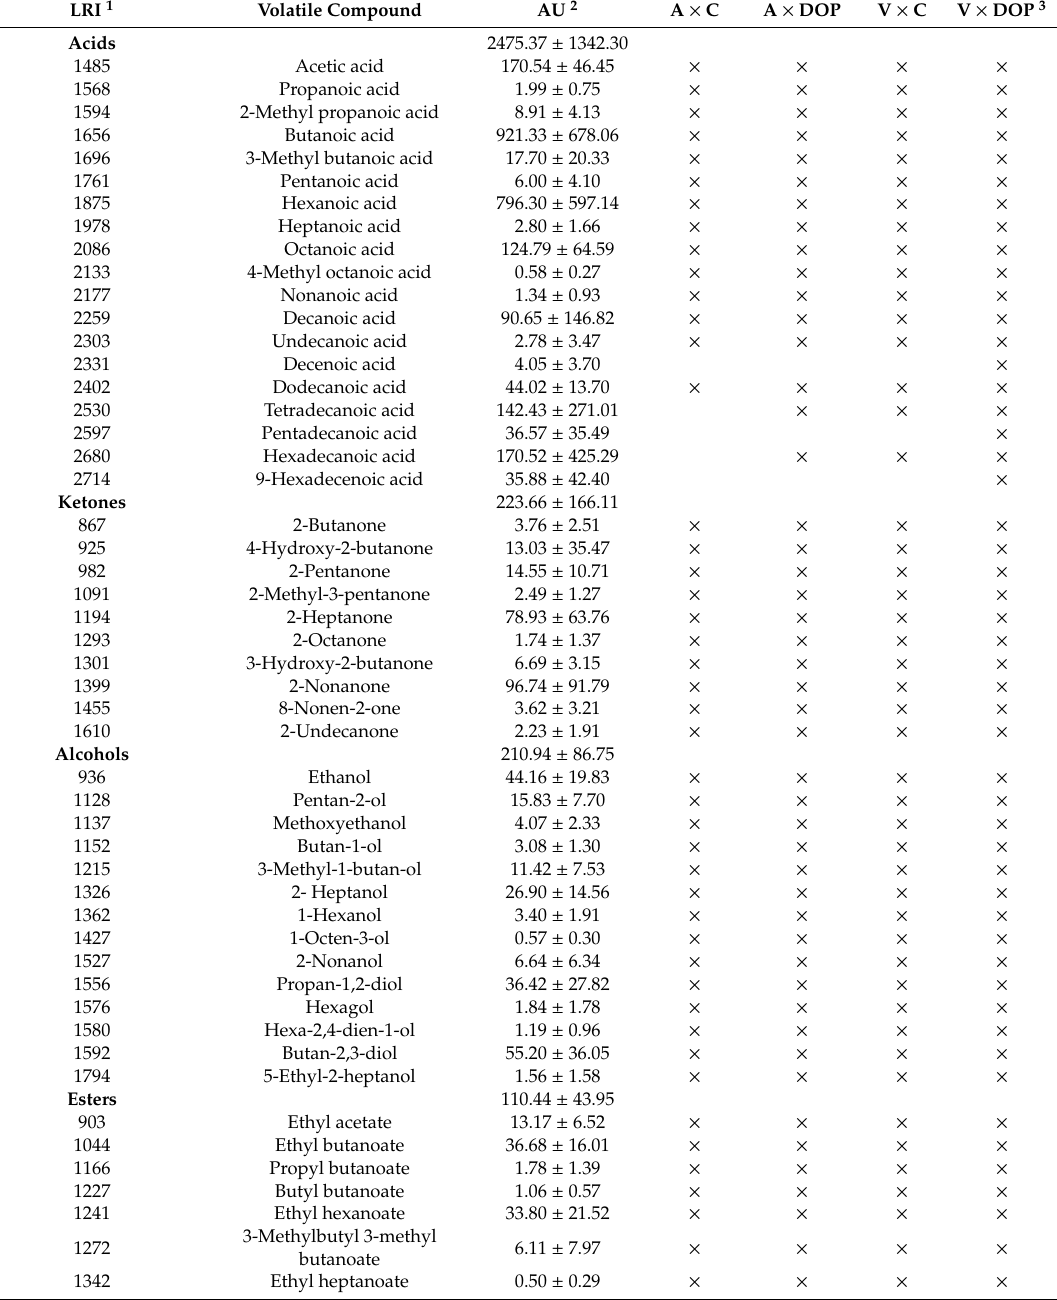
Table 4. Mean and standard deviation of volatile compounds isolated from Payoya goat